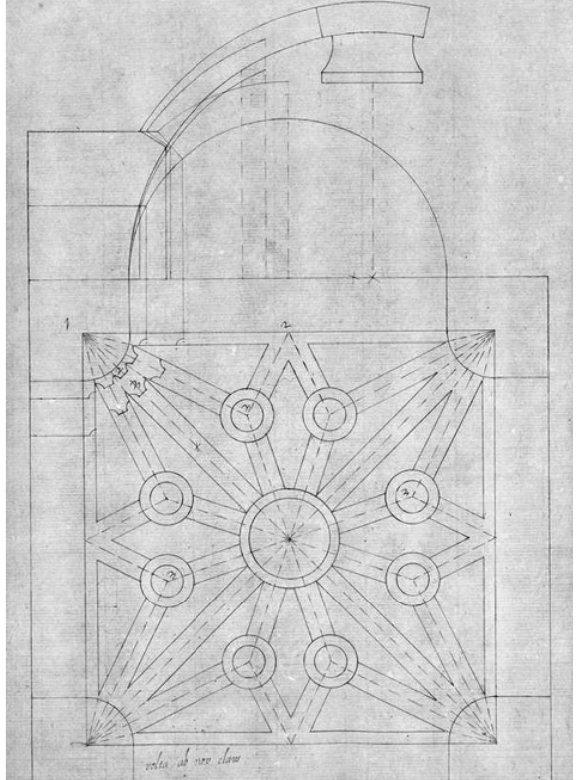
Figure 1 . Curvatures of the ribs in a drawing by Willis.